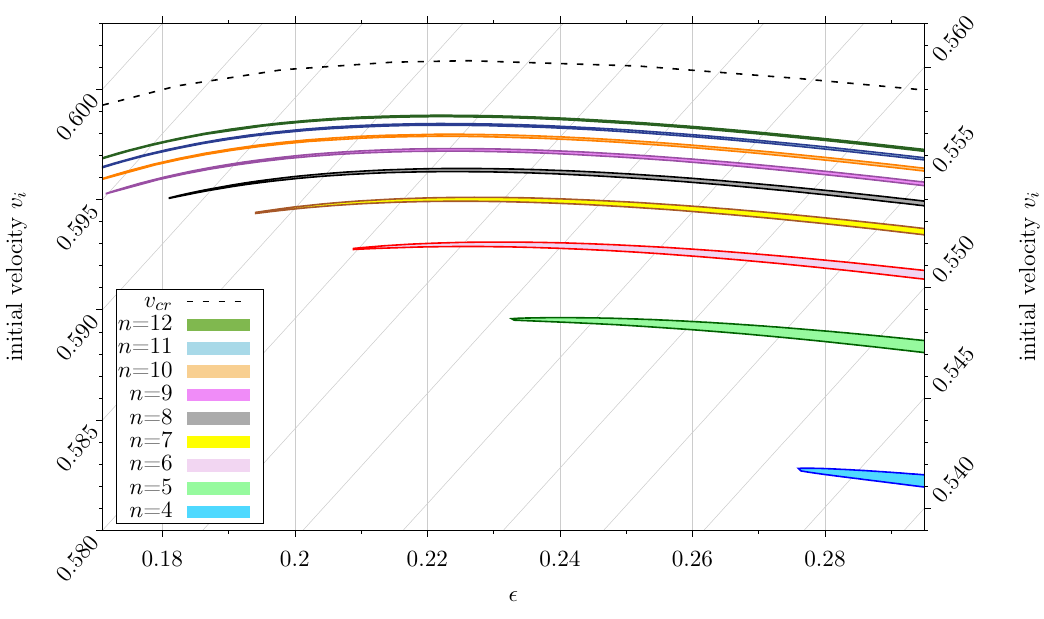
Figure 15 . The closing two-bounce windows as a function of both (cid:15) and initial velocity v i in a sheared coordinate system to reduce the high inclination of the